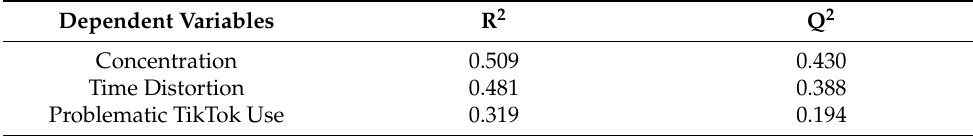
Table 8. Model results for R 2 and Q 2 .